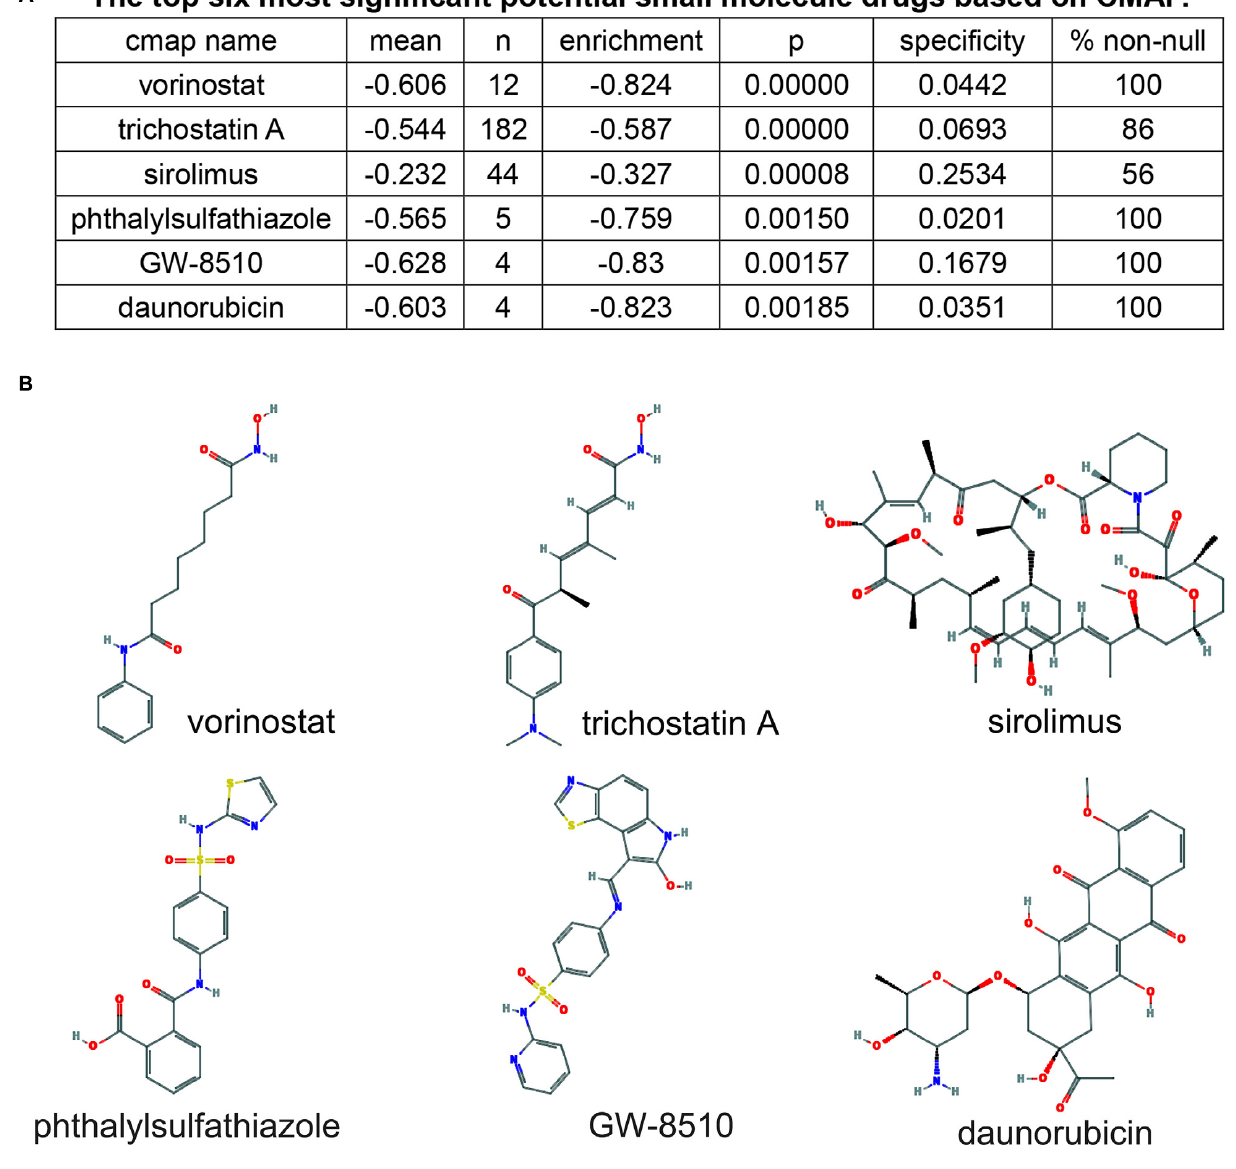
FIGURE 8 | Screening of six pancreatic cancer candidate small molecule drugs. (A) The top six most significant potential small molecule drugs based on cMAP. (B) The chemical structure depiction of the six candidate small molecule drugs for